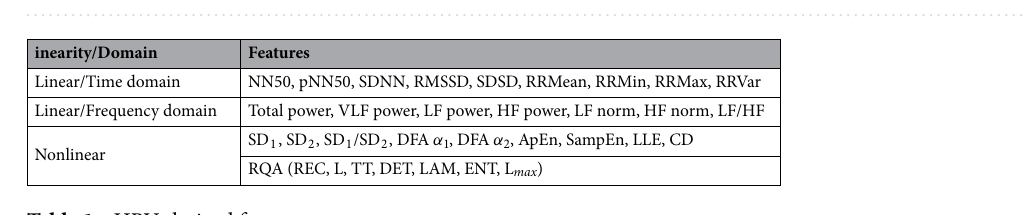
Table 1. HRV-derived